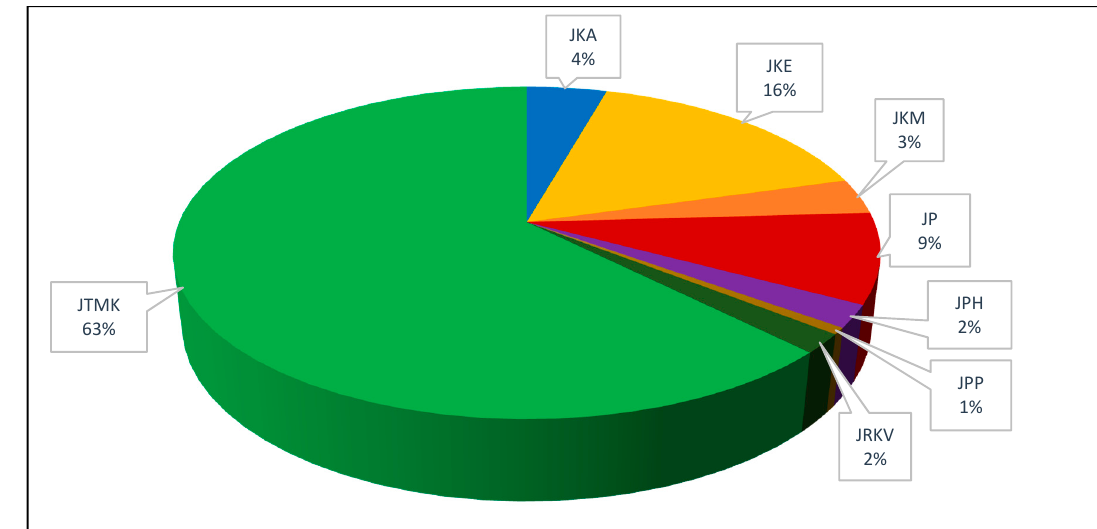
Figure 2. Distribution of respondents by the department.